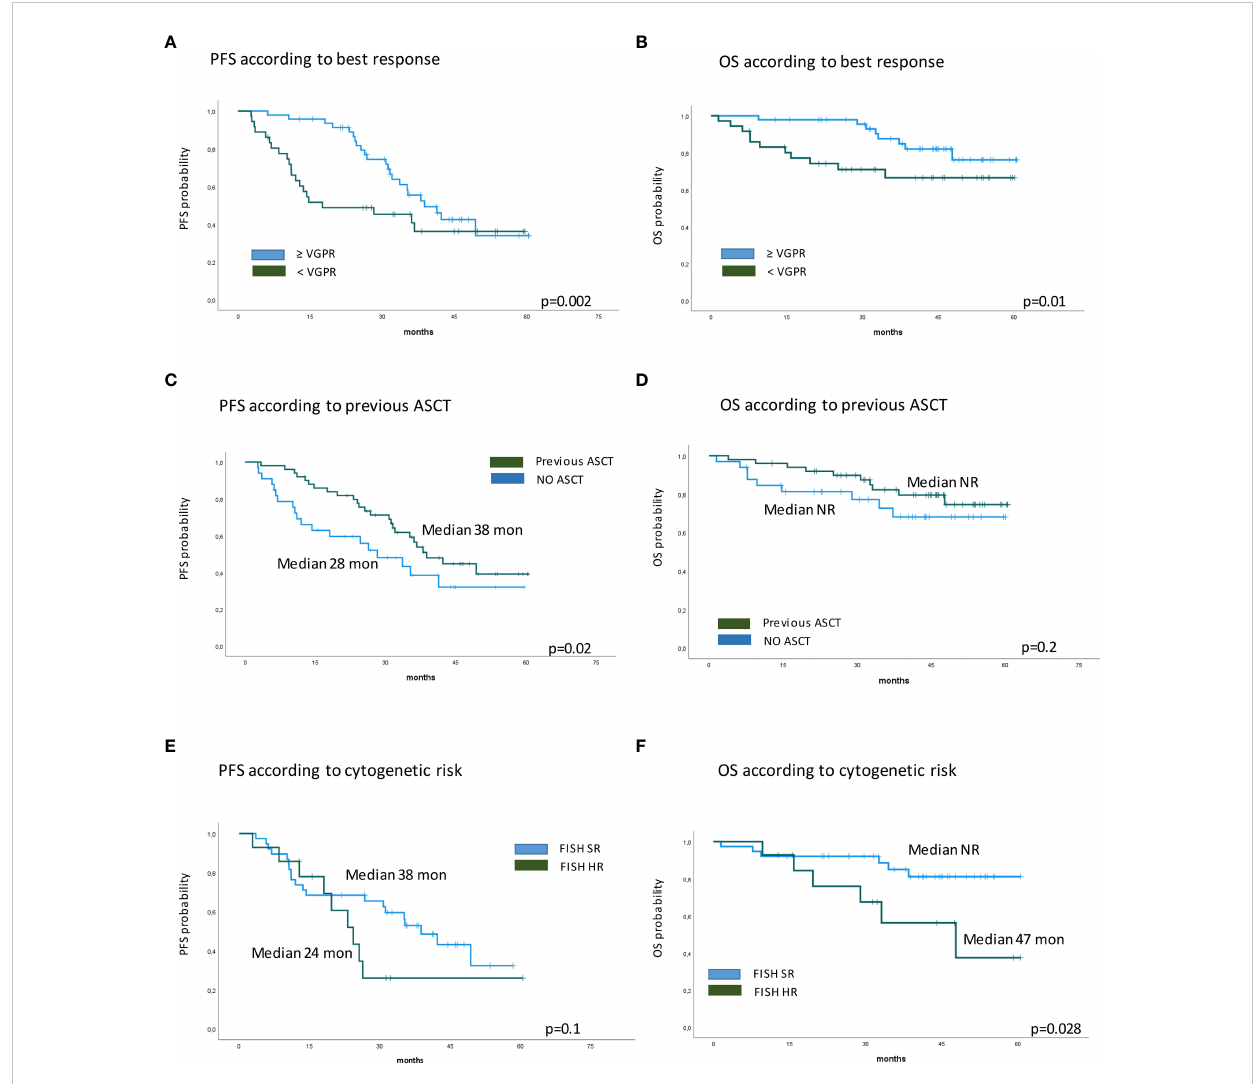
FIGURE 3 Kaplan – Meier survival curves. (A) PFS according to best response. (B) OS according to best response. (C) PFS according to previous ASCT. (D) OS according to previous ASCT. (E) PFS according to cytogenetic risk. (F) OS according to cytogenetic risk. PFS, progression-free survival; OS, overall survival; ASCT, autologous stem cell